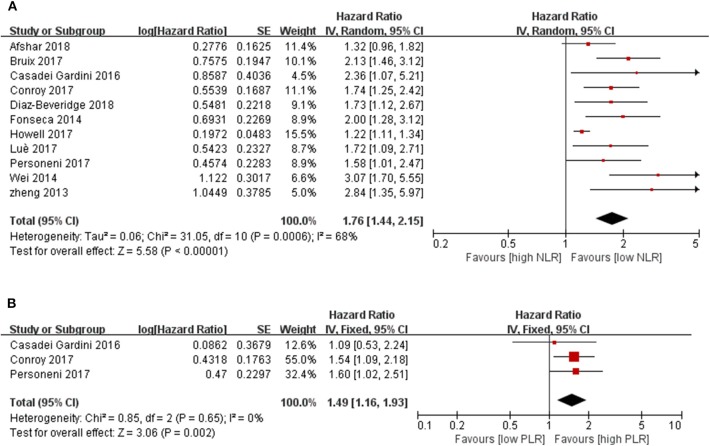
Forest plots for associations between pretreatment (A) blood NLR and survival, (B) blood PLR and survival.